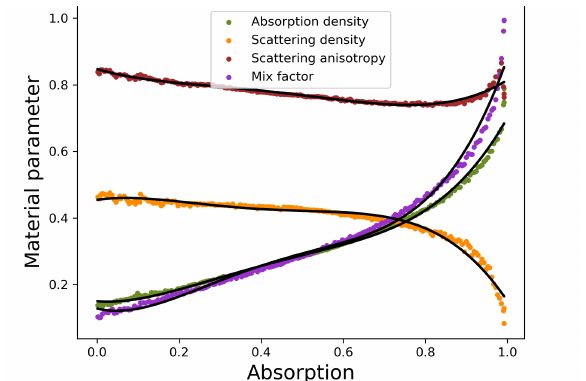
Figure 3. Material parameter starting guess optimized using Equation (2) for r m and t m . Dots indicate data points optimized for each material parameter. Black curves show fourth order polynomial fit to each set of